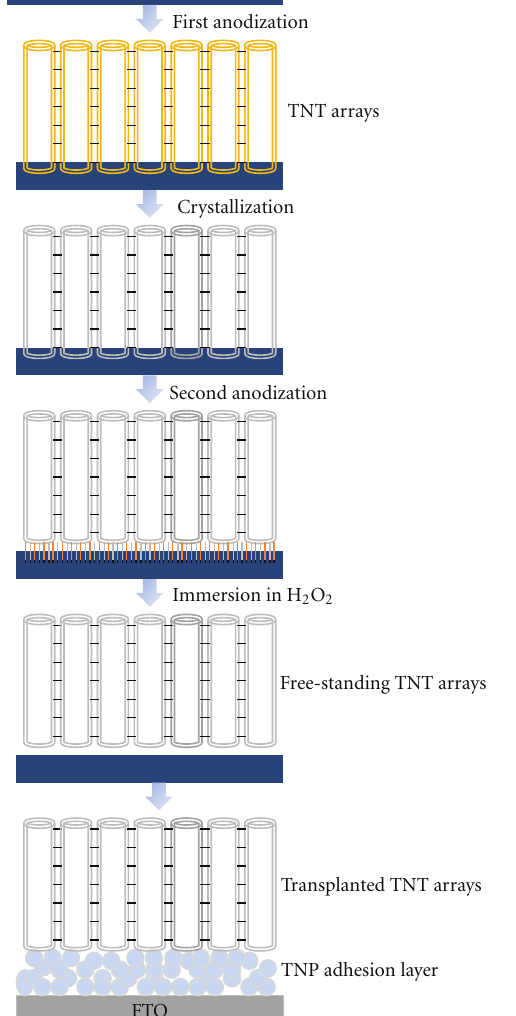
Figure 1: Schematic for the preparation of anodized TNT arrays, detachment, and transplantation onto